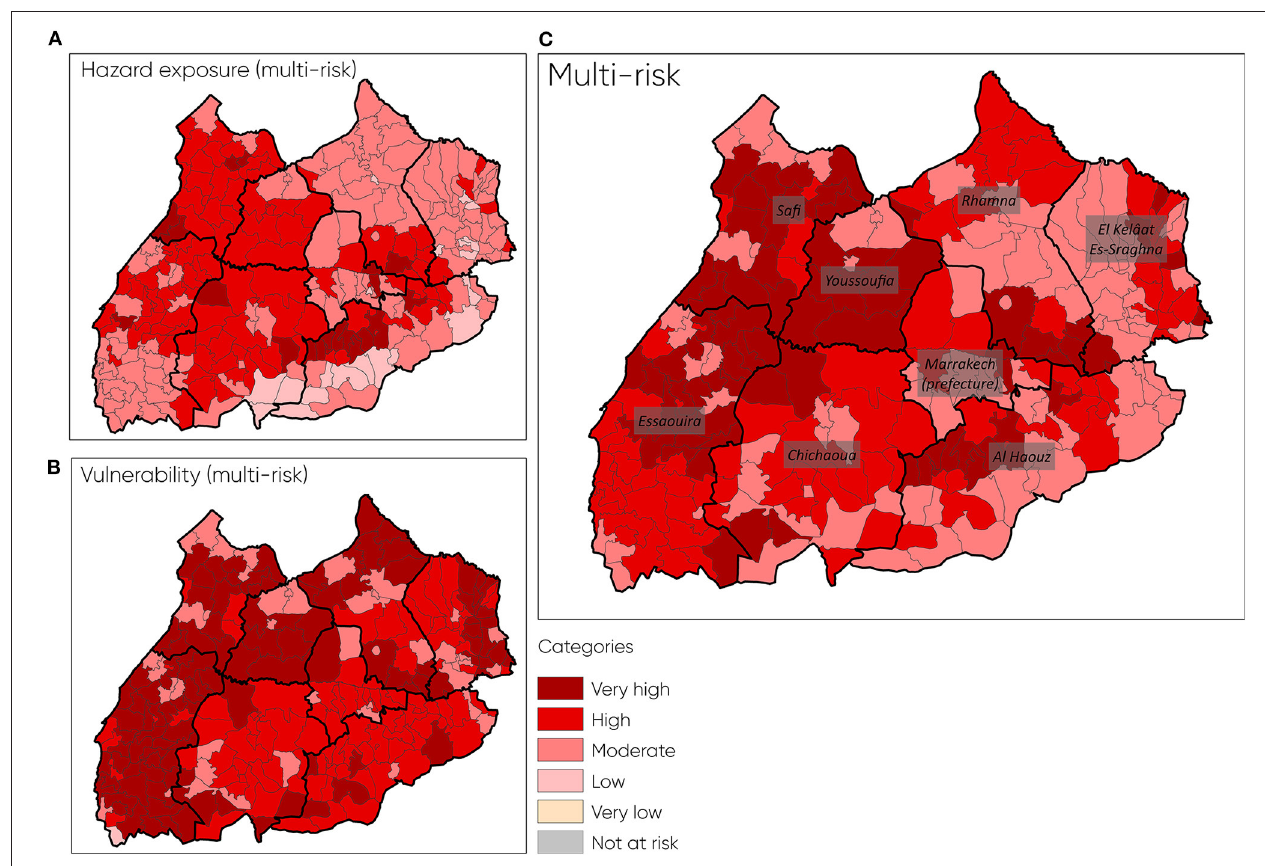
FIGURE 6 | Results of the spatial assessment of multi-risk of Marrakech-Safi: multi-risk spatial exposure (A) , multi-risk vulnerability (B) , and overall multi-risk (C) .